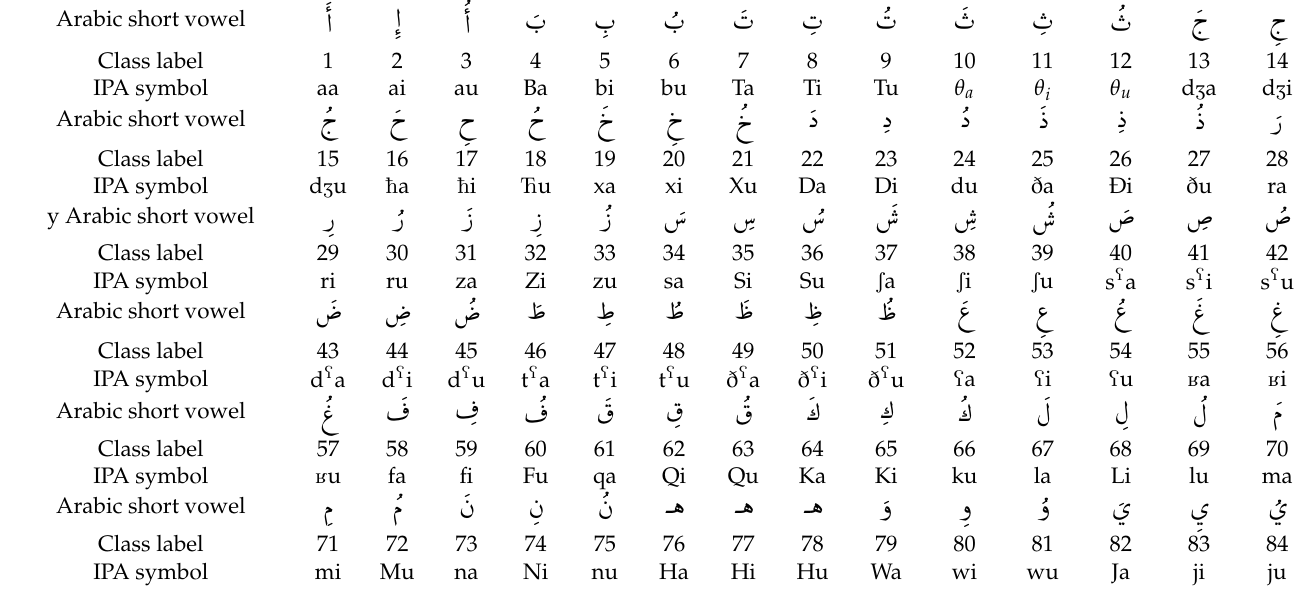
Table 2. Representation of Arabic Short Vowels (ASV) with Class Label (CL) in IPA and native script along. Arabic short